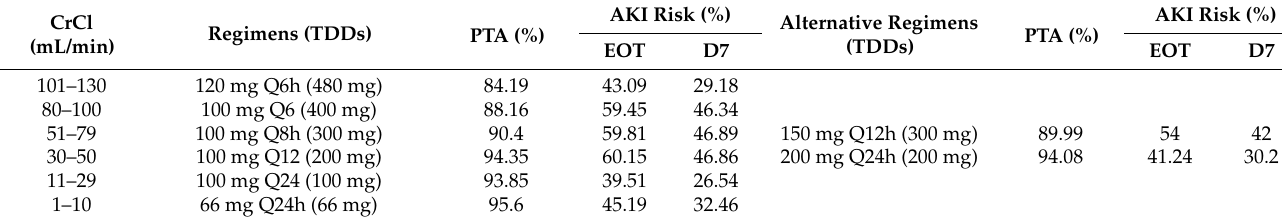
Table 6. Recommendation for MIC of 1